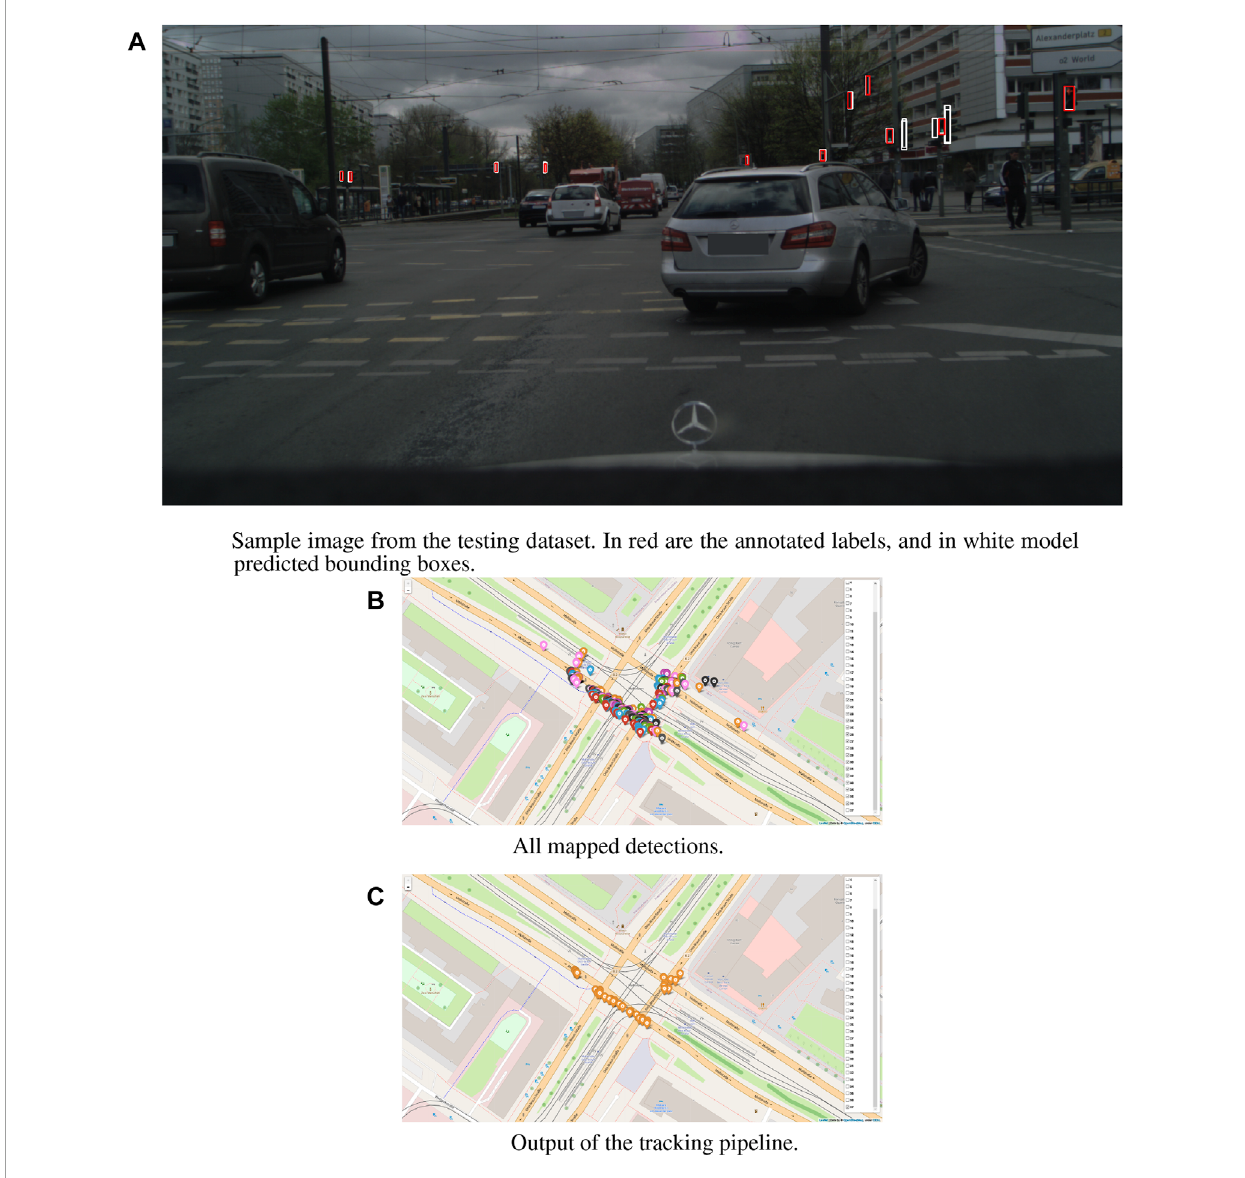
FIGURE 1 Core components of the traffic lights-HD map creation pipeline. The output of the network with lights positioned on the image plane (A) . Georeferenced position of the lights (B) . And the tracked position of the lights (C) .